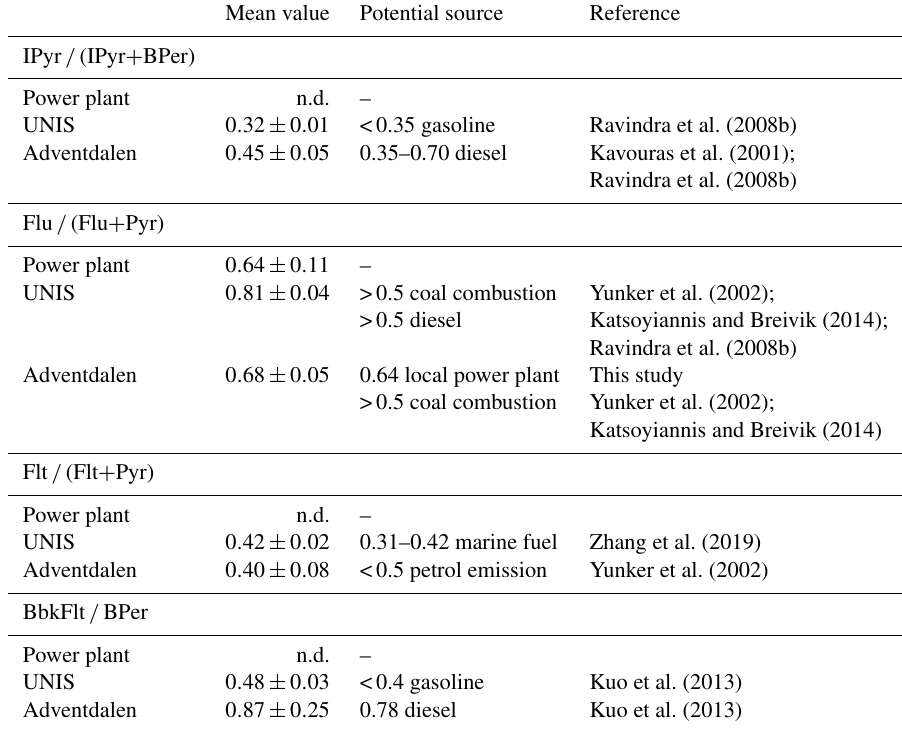
Table 3. Source identification based on diagnostic ratios derived from total (G + P) concentrations; averages of individual ratio values ( n = 6) with standard deviation are